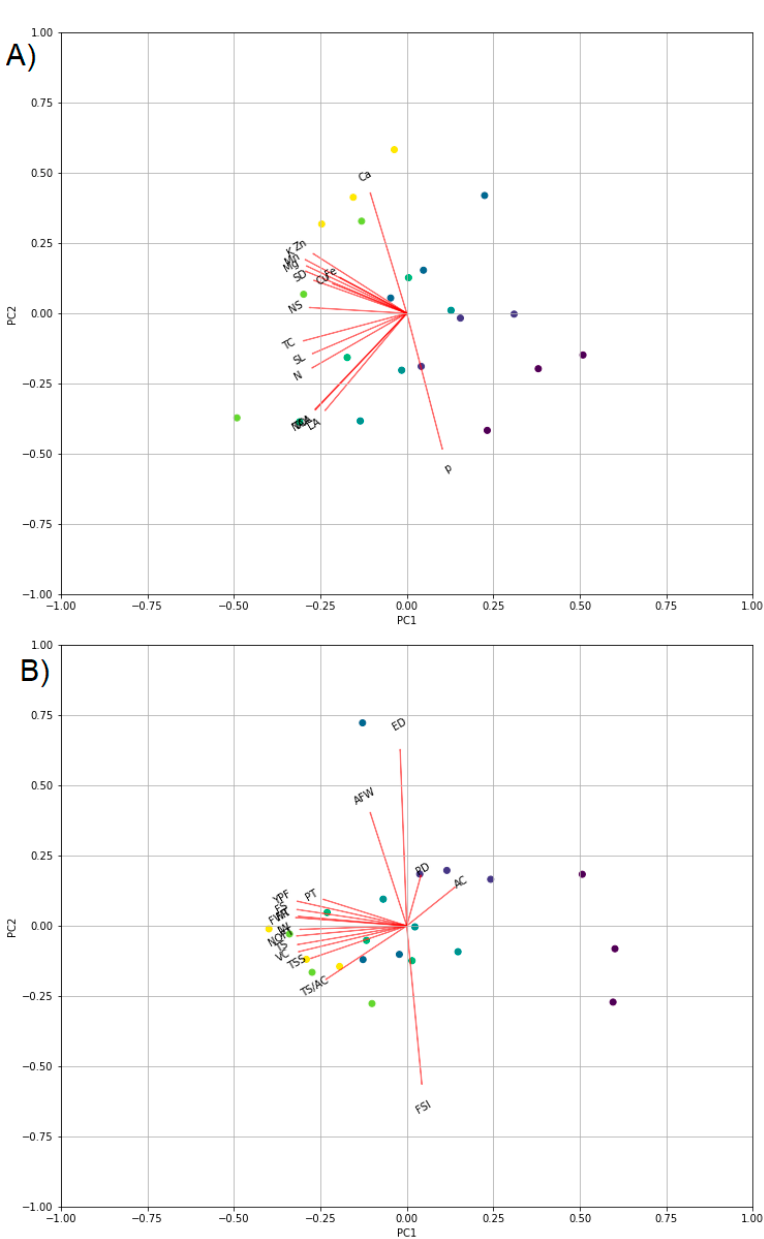
Figure 1. Principal component analysis (PCA) to show the correlation between treatments (scores) and crop features (loadings). A represents PCA for the corresponding treatments and the vegetative growth, chlorophyll, and mineral contents, while B represents PCA for the corresponding treatments and fruit aspects and quality. Treatments are control, Fe-NPs 1, Fe-NPs 2, FeSO 4 (0.1%), FeSO 4 (0.2%), Fe-chelated (0.05%), and Fe-chelated (0.1%) for T1, T2, T3, T4, T5, T6, and T7, respectively. The treatments were gradually colored from dark blue (control) to green (T7). The vegetative growth features and minerals ( A ) included No. of new shoots (NS), shoot length (SL), shoot diameter (SD), No. of leaves per shoot (NOL), leaf area (LA), assimilation area (TAA), total chlorophyll (TC), chlorophyll A (CA), chlorophyll B (CB), carotenoids (CAR), nitrogen (N), phosphorus (P), potassium (K), calcium (Ca), magnesium (Mg), iron (Fe), manganese (Mn), and zinc (Zn). The yield and quality aspects ( B ) included fruit set (FS), fruit retention (FR), No. of fruits per tree (NOFT), average fruit weight (AFW), yield per tree (FWT), total yield (YPF), peel diameter (PT), polar diameter (PD), equatorial diameter (ED), fruit shape index (FSI), juice weight (JW), juice, % (J), total soluble solids (TSS), Total acidity, % (TA), TSS/acid ratio (TS/AC), total sugars (TS), (V.C) and shelf life (SLIF).